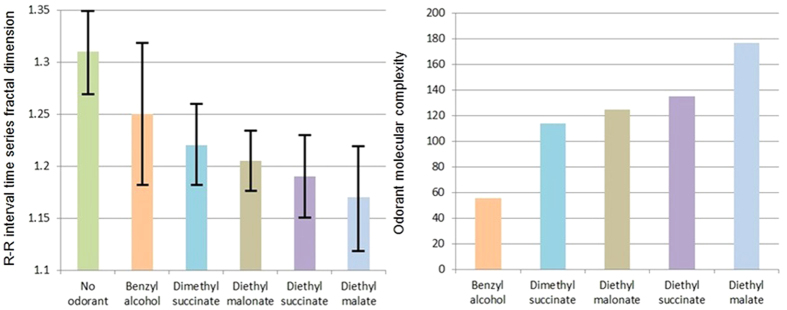
Fractal dimension for R-R interval time series due to different odorants (left side), and the odorants’ molecular complexities (right side).Error bars indicate standard deviations.